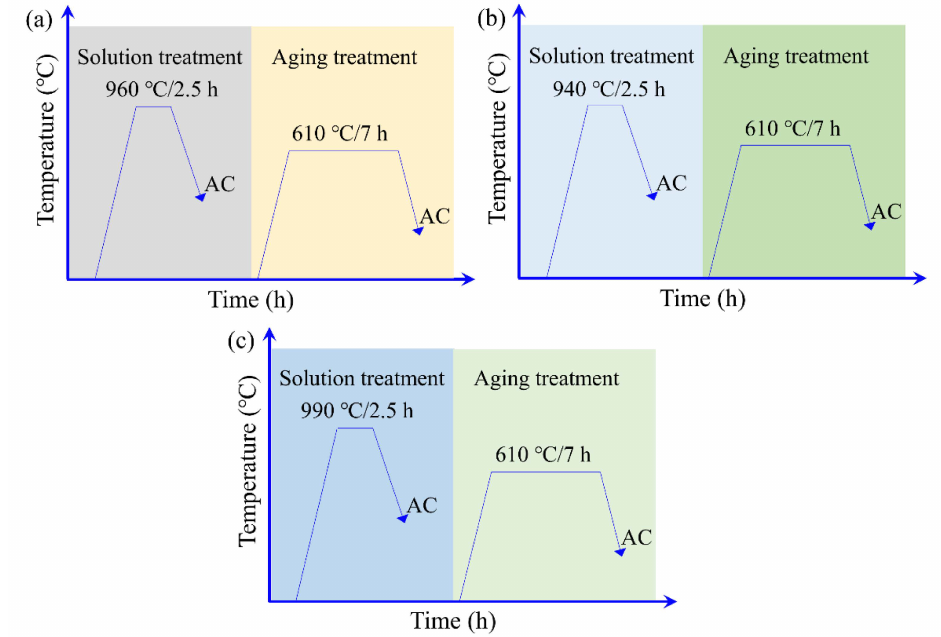
Figure 12. Schematic illustration of heat treatment: ( a ) the first heat treatment, ( b ) the second heat treatment, and ( c ) the third heat